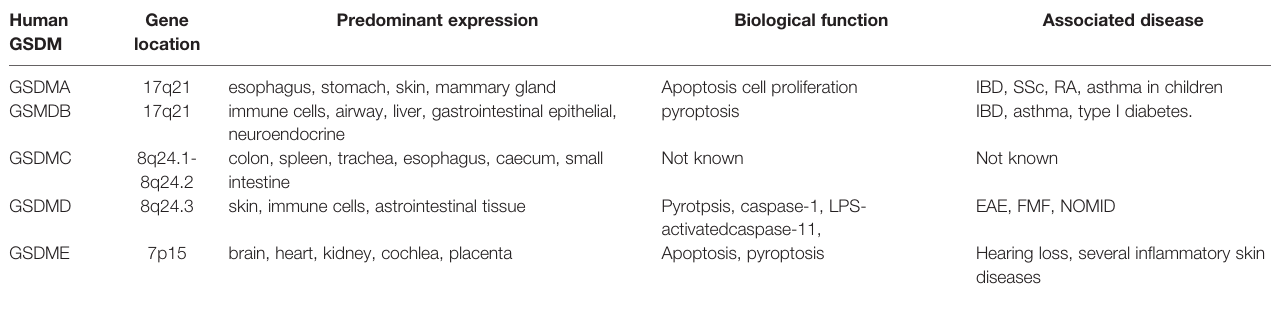
TABLE 1 | Gasdermin family members, functions, and disease